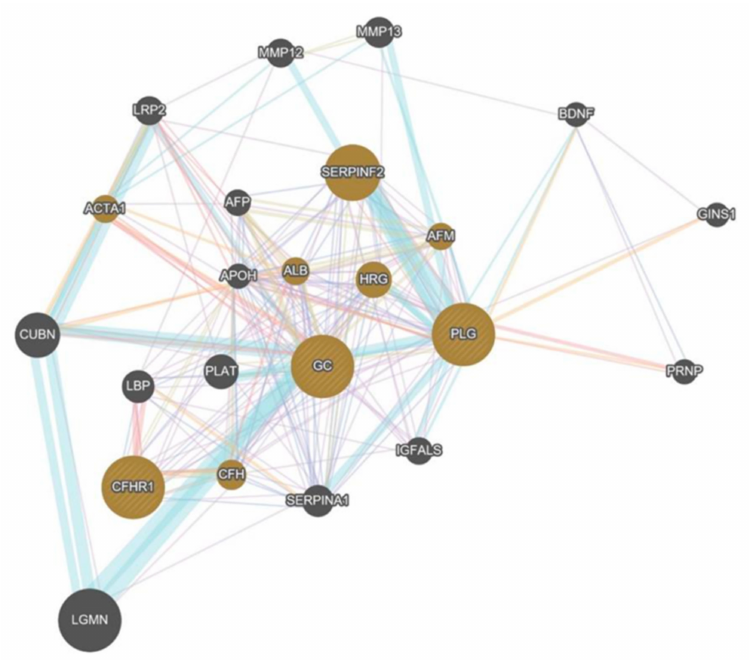
Figure 4. Bio-Informatical Analysis of HH30 vs. GC30. A 2-fold change was set as the threshold of regulation for the quantitative